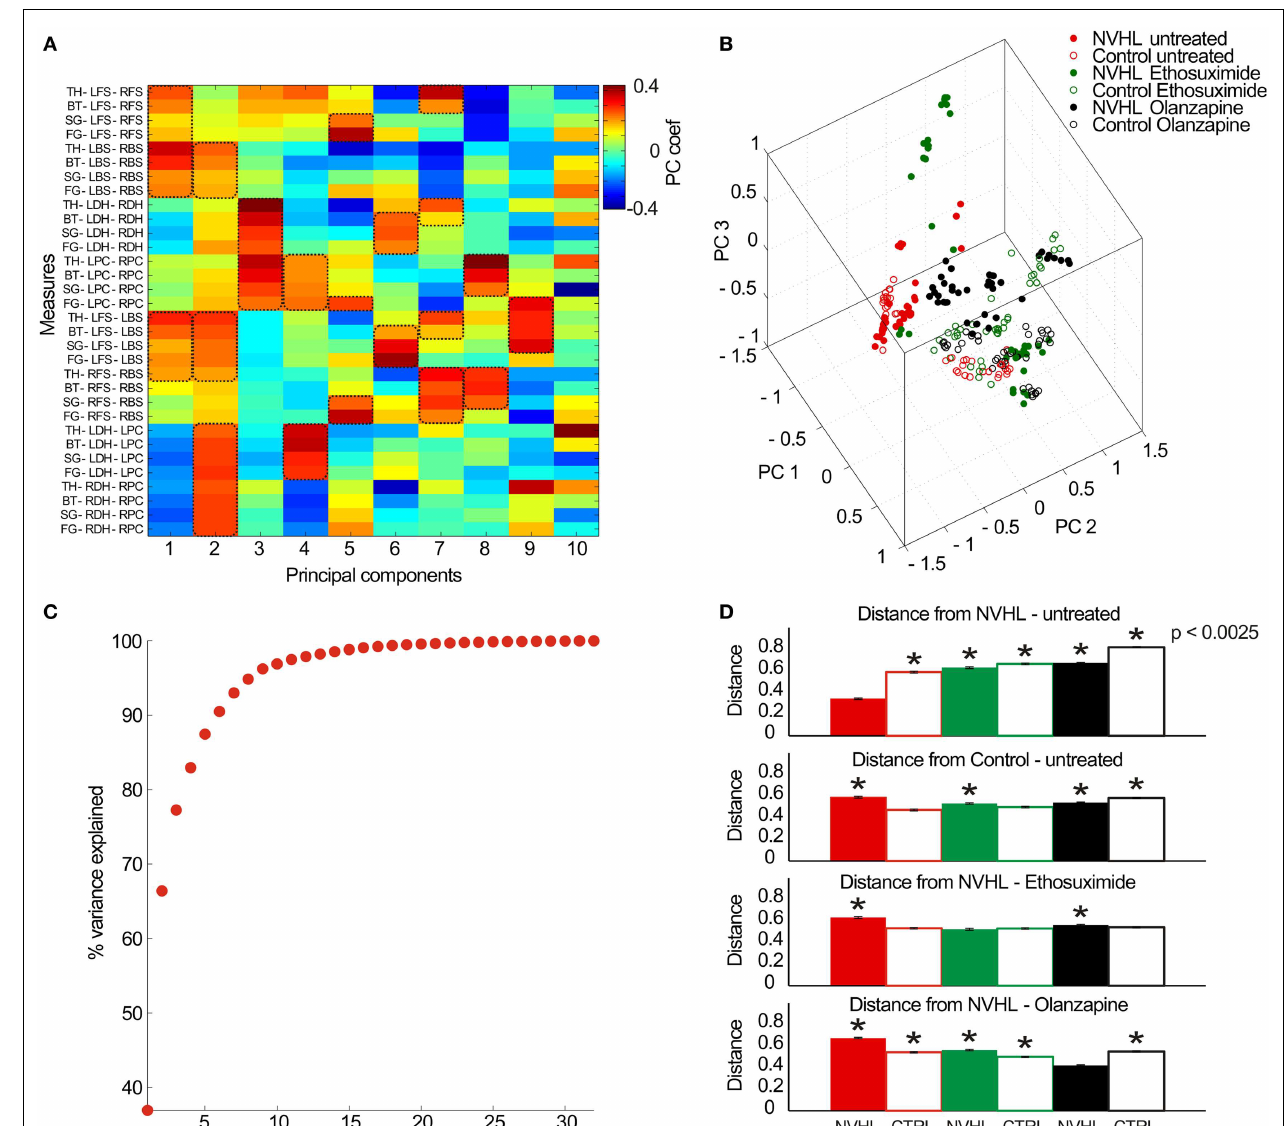
slow gamma, and fast gamma bands between inter-hemispheric neocortical and hippocampal sites.The key measures of synchrony that contributed to each PC are indicated by the dashed boxes. (B) The multidimensional data can be visualized by plotting in the 3-D space of the first three PCs. (C) The cumulative probability of the dataset variance is explained by the PCs.The first six principal components explain ~90% of the dataset variance. (D) The average Euclidean distance between a pair of vectors estimates their distinctiveness.The distances between all pairs of vectors were computed within a treatment group and between all treatment groups and a specific treatment group to estimate similarity/distinctiveness of the treatment groups.The average distances are given to the untreated NVHL group (top row), to the untreated control group (second row), to the ethosuximide-treated NVHL group (third row), and to the olanzapine-treated NVHL group (bottom